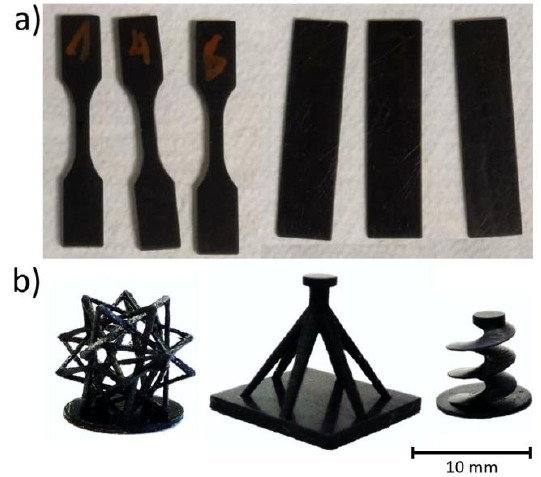
Figure 1. Examples of 3D printed parts with 0.100 wt % CNT. ( a ) Tensile and three-point bending test specimens and ( b ) complex geometry parts.